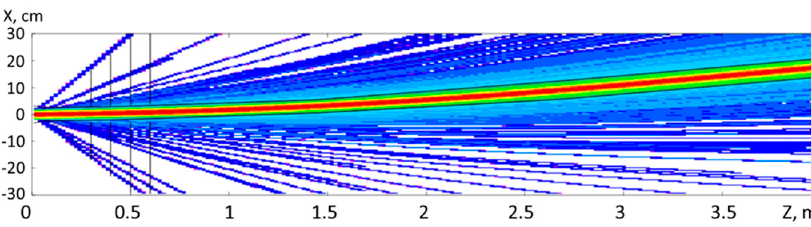
Figure 4. Projection of the beam particles in the X – Z plane illustrating the beam deflection as calculated with the FLUKA code for an Au beam with a kinetic energy of 4.5 A GeV, a profile with a width of σ = 3.5 mm, and a divergence of 1 mrad.